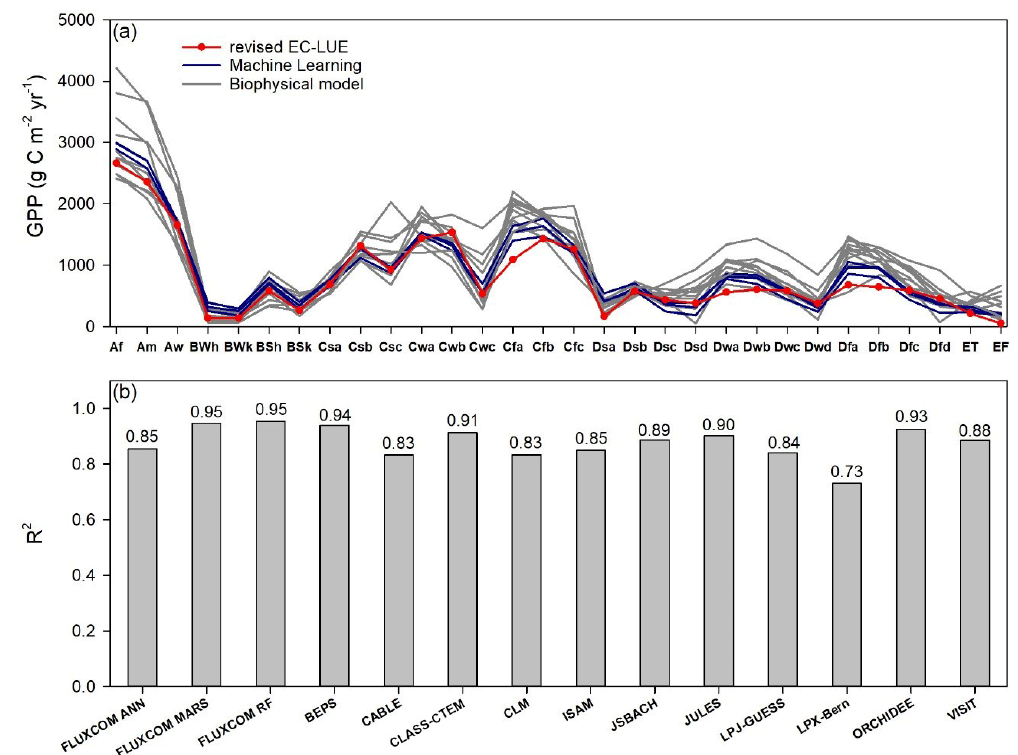
Figure 9. Comparisons of long-term (1982 to 2010s) averaged GPP between the revised EC-LUE model and other models across bioclimatic zones in the Köppen–Geiger climate classification map (Beck et al., 2018). (a) The regional averaged value (b) correlation coefficients ( R 2 ) of GPP across all the bioclimatic zones between the revised EC-LUE model and other models. These models include three machine learning models (FLUXCOM ANN, FLUXCOM MARS, FLUXCOM RF; Jung et al., 2017), the biophysical model BEPS (Ju et al., 2006; Liu et al., 2018), and 10 biophysical models in TRENDY (CABLE, CLASS-CTEM, CLM, ISAM, JSBACH, JULES, LPJ-GUESS, LPX-Bern, ORCHIDEE, and VISIT). The abbreviations for the bioclimatic zones are as follows: Af, tropical, rainforest; Am, tropical, monsoon; Aw, tropical, savannah; BWh, arid, desert, hot; BWk, arid, desert, cold; BSh, arid, steppe, hot; BSk, arid, steppe, cold; Csa, temperate,